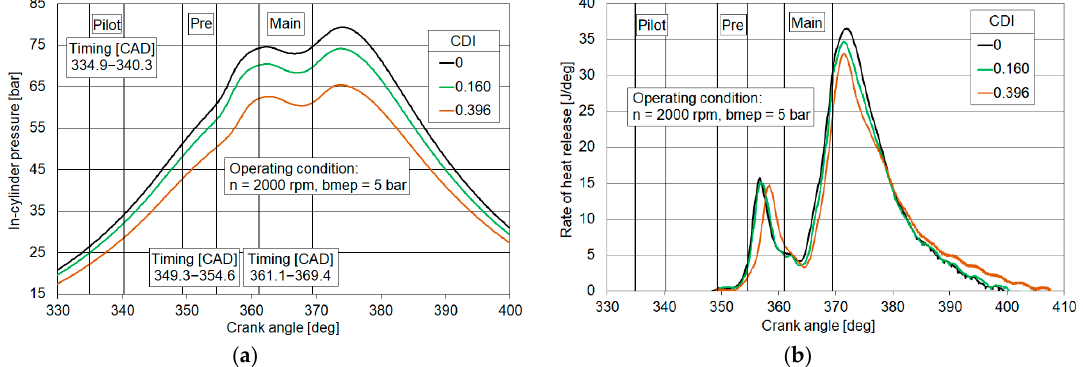
Figure 4. Influence of Exhaust Gas Recirculation (EGR) rate on pressure diagrams ( a ) and heat release; ( b ) (High Pressure, HP, loop activation).